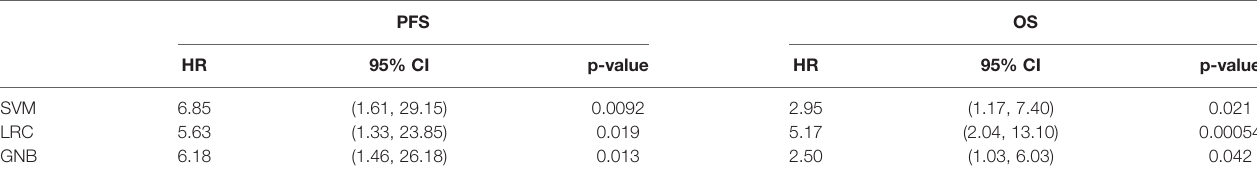
TABLE 3 | Summary of data analyses of three cox regression models for PFS and